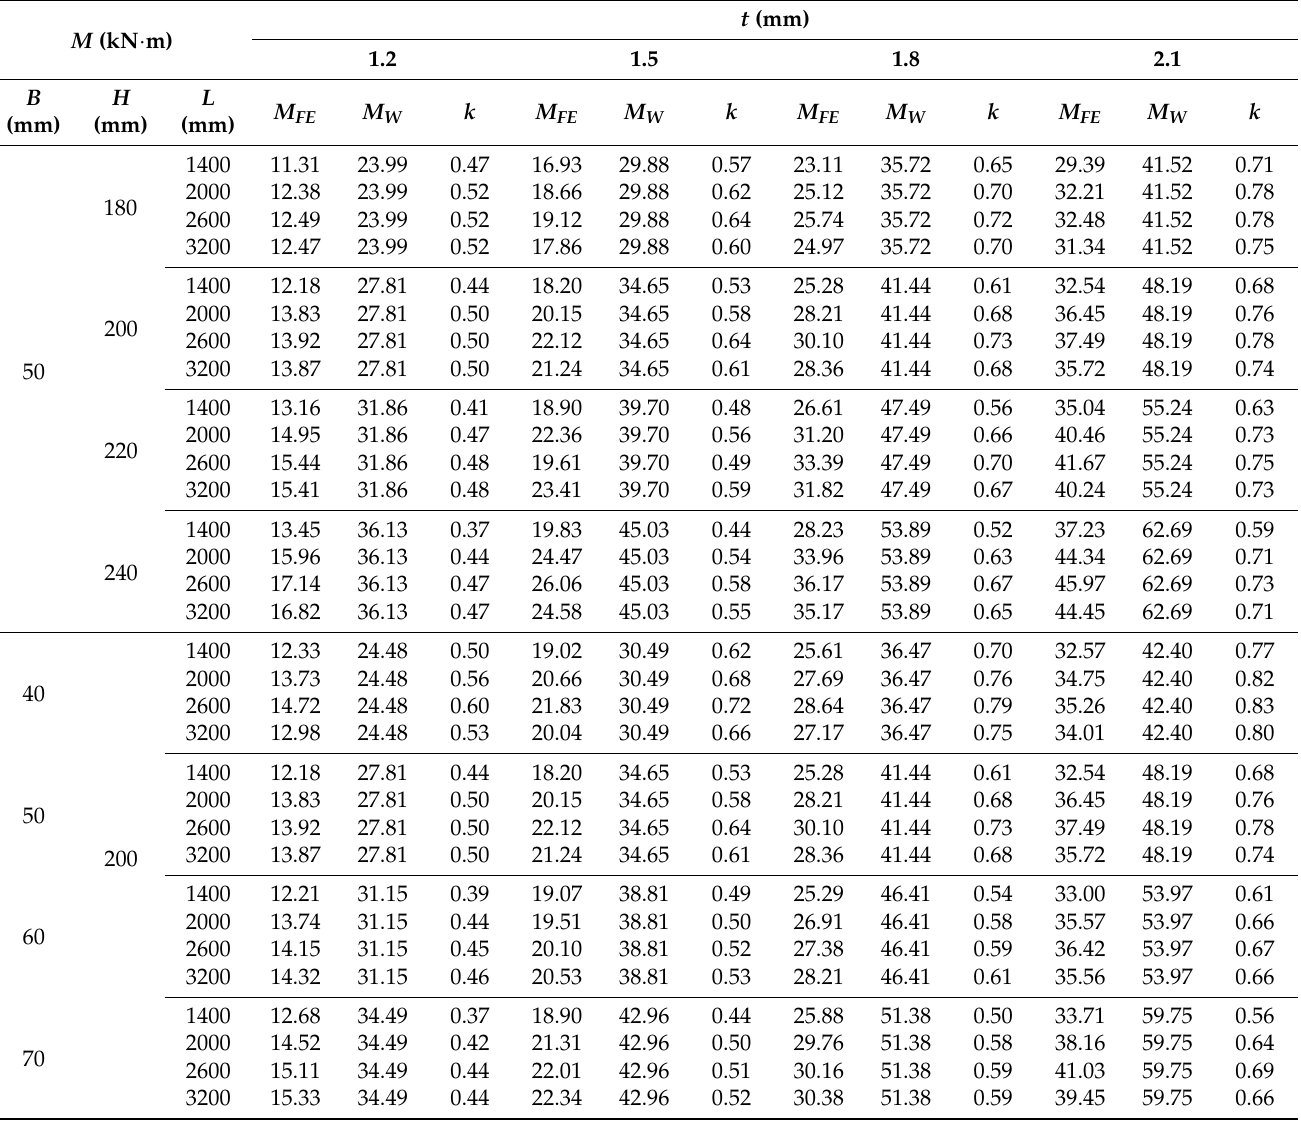
The B 0 /t a ratio decreases with the increase of the thickness (1.2–2.1 mm). The flexural moment capacity increases significantly with the increase of the thickness. This phenomenon is mainly because of the significant increase of the effective bending moment modulus. Table 4. Summary of the flexural moment capacities for B4